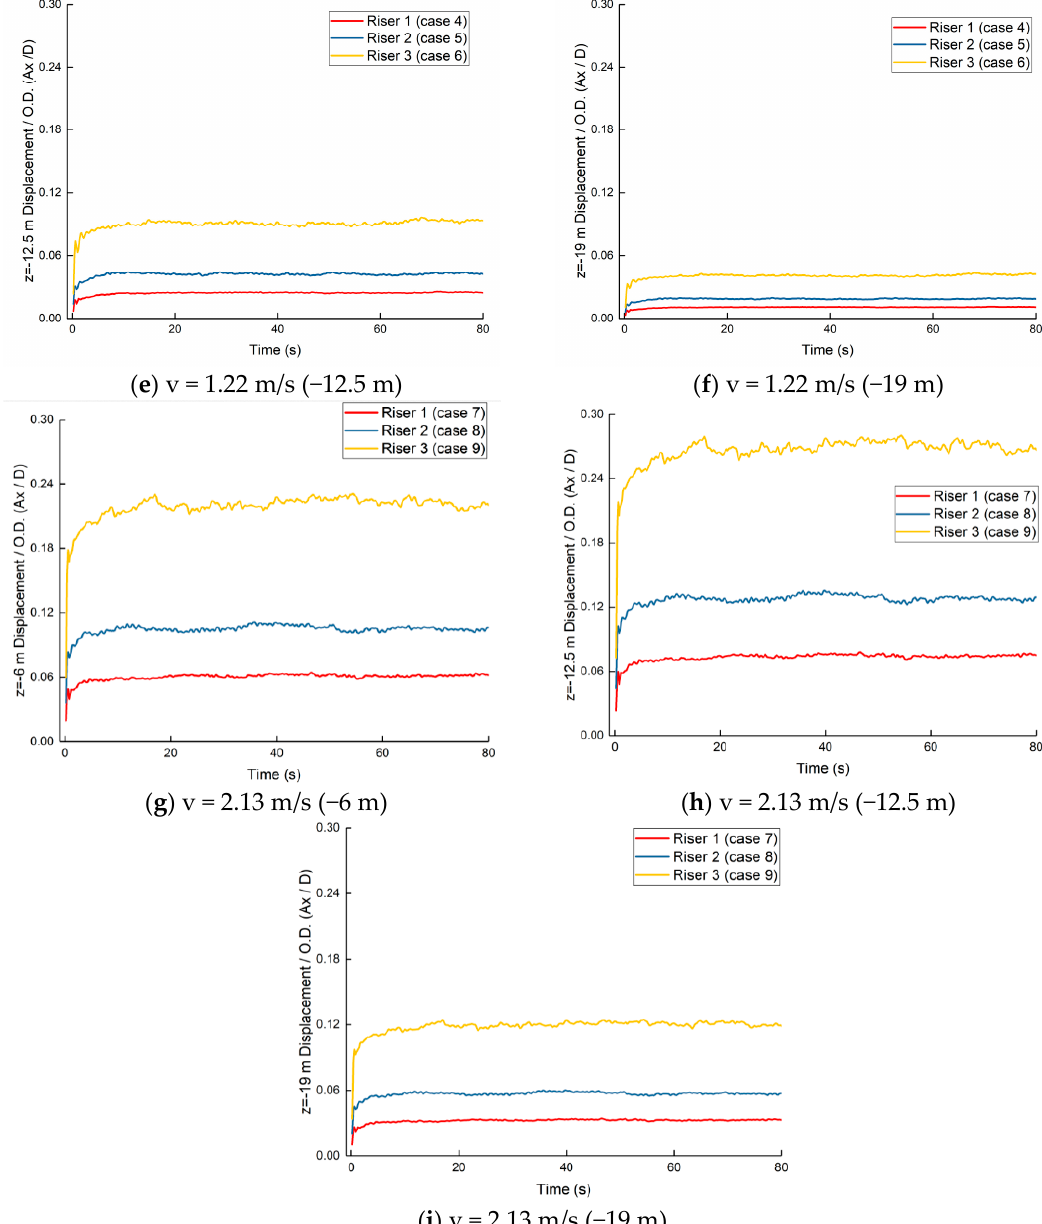
Figure 6. Time history of displacements in in ‐ line flow direction (X) at three typical locations.